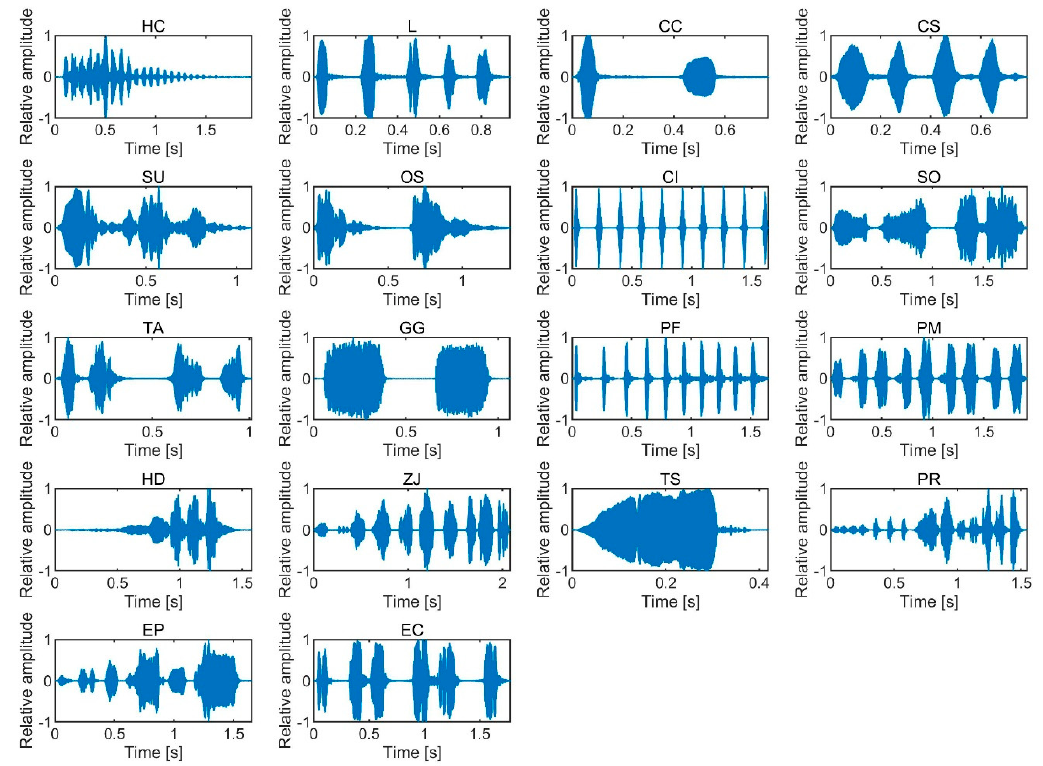
Figure 1. Temporal waveforms of the 18 birdsong stimuli used.